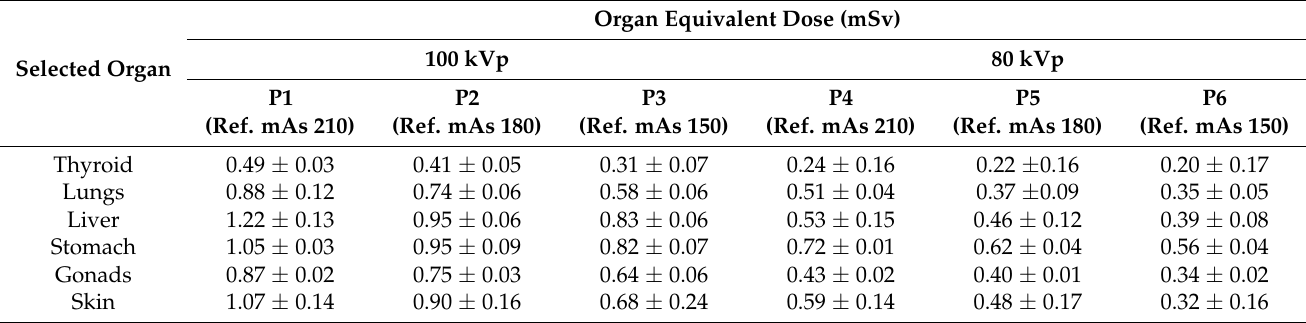
Table 2. Organ Equivalent Dose from TLD measurement between 100 and 80 kVp with variation ref. mAs.